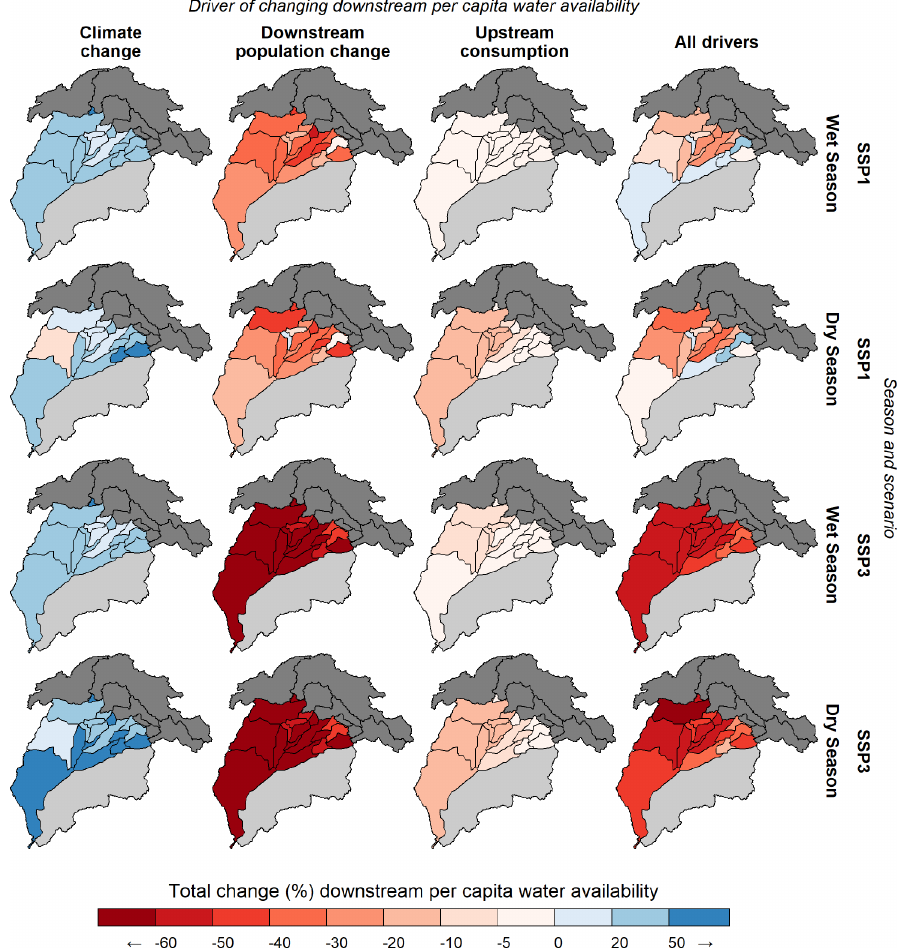
Figure 7. Isolated impact of climate change, downstream population change and upstream consumption on seasonal lower Indus water availability in the Late period (i.e. compared to the Late period situation without the effect of the respective driver). Additionally, the change in Late period water availability with all drivers considered is compared to reference period water